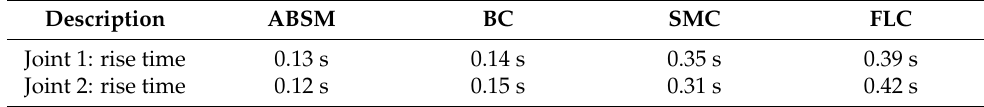
Table 4. Performance index of ABSM, BC, SMC, and FLC with unit step response.